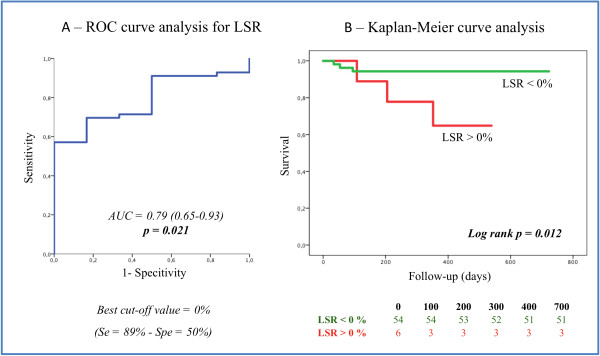
Prognostic value of LSR A. Kaplan-Meier curve representing the impact of a positive LSR on all-cause mortality in Panel B. LSR = longitudinal strain reserve. AUC = area under the curve, Se = sensitivity and Spe = specitivity.